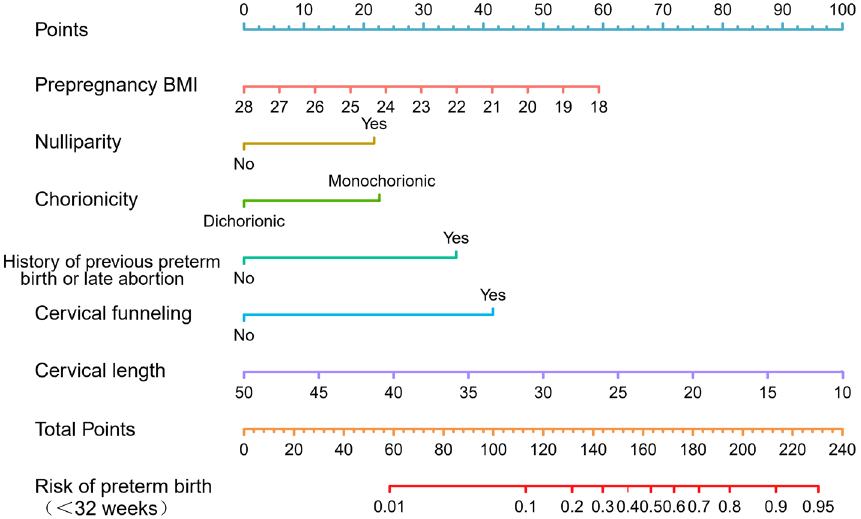
Figure 3. Nomogram for the prediction of PTB < 32 weeks based on six independent risk factors. To calculate the probability of PTB < 32 weeks in twin pregnancies, the point for each variable is assigned by the corresponding value of the "point" axis, and points are plotted on the total points axis. The comprehensive risk of PTB at < 32 weeks for twin pregnancy corresponds to the total points.